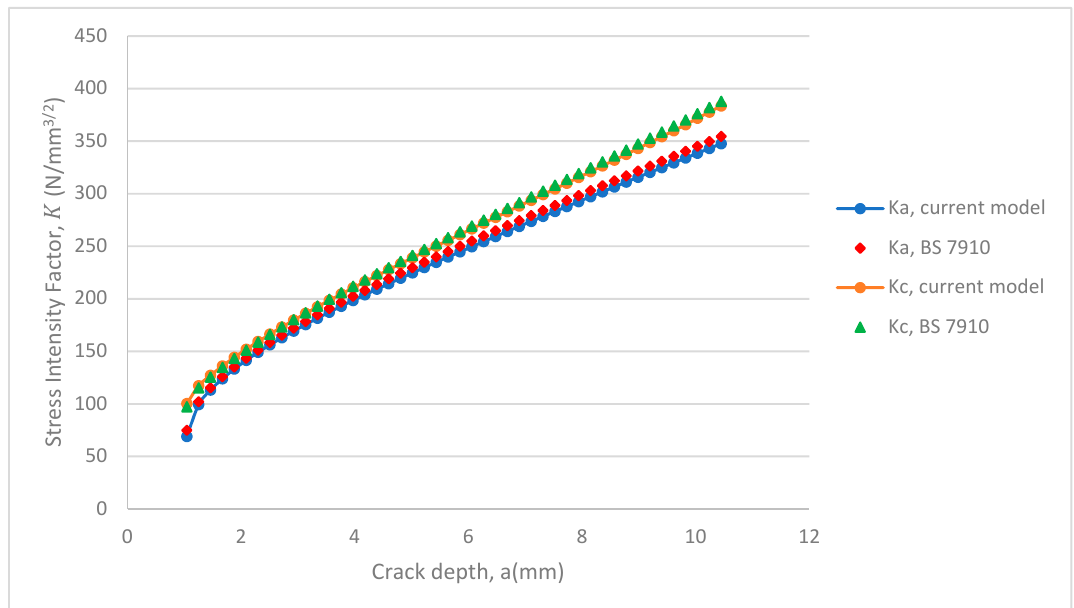
Figure 22. SIFs at the deepest point ( K a ) and surface point ( K c ) for an external semi-elliptical crack in a pipe under cyclic tension (initial a/c = 1.6).